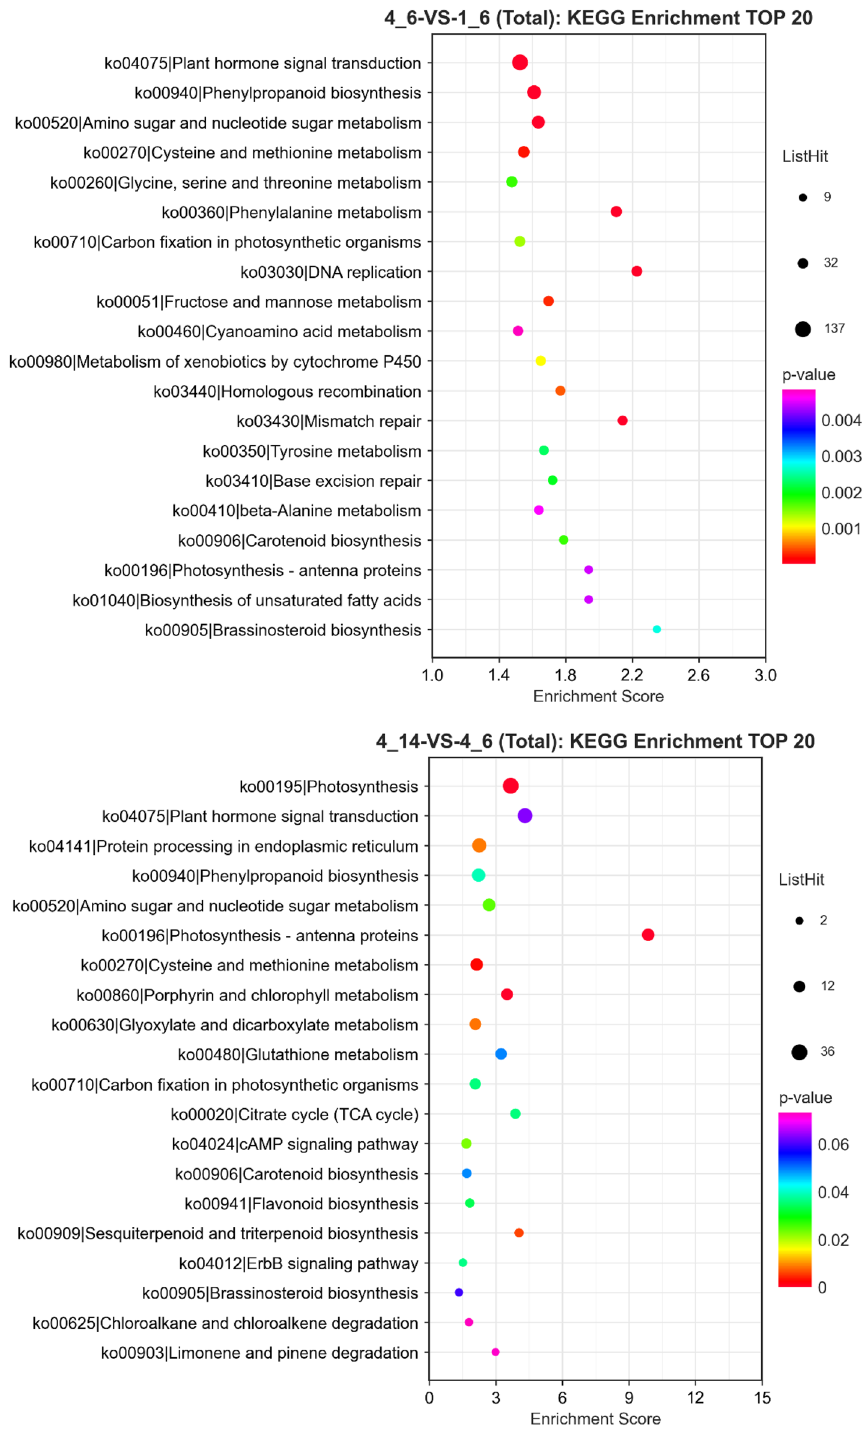
Figure 5. Kyoto Encyclopedia of Genes and Genomes (KEGG) enrichment analysis of different treatments. The larger the bubble, the greater the number of differential protein-coding genes contained in the entry. The bubble color changes from purple to blue to green to red. The smaller the enrichment P value, the more significant greater the